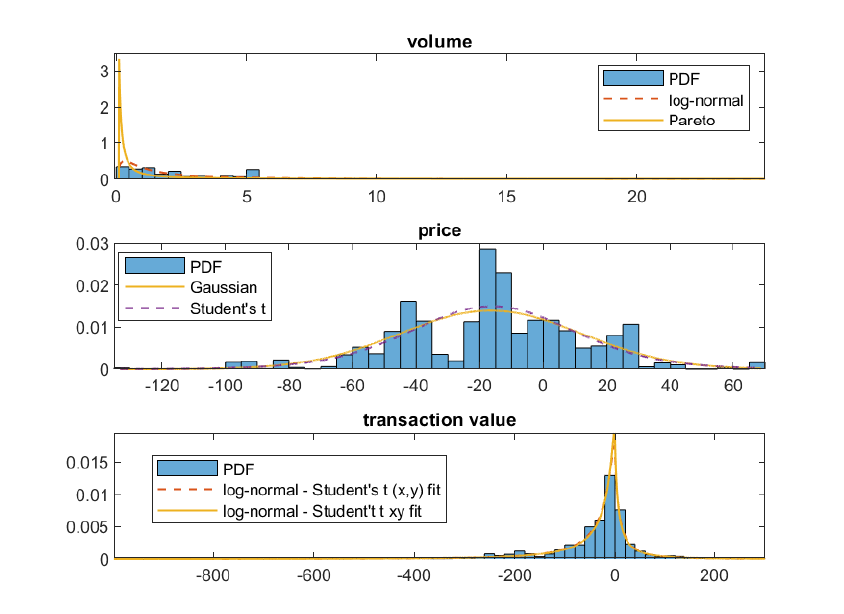
Figure 14. Probability distribution of the volume ( top panel ), price ( middle panel ) and their product, i.e., the transaction value ( bottom panel ) from the continuous intraday energy market data on 15 March 2020, hour 8. The fitted PDFs are also plotted. The transaction value densities are fitted in two ways: separately to the x (price) and y (volume) data (denoted by ‘ ( x , y ) fit’) or to the product xy (transaction value) data (denoted by ‘ xy